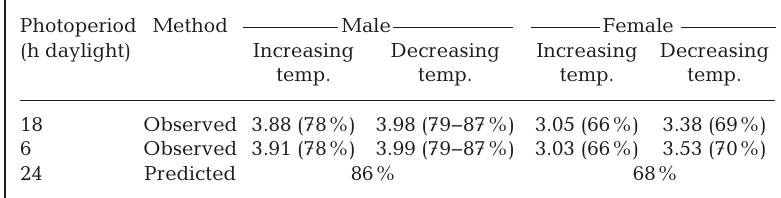
Table 6. Effects of temperature gradient and light regime on Lepeophtheirus salmo- nis development. The table shows the mean number of molts undertaken by males and females when temperatures increase from 6 to 11.4°C during development to preadults in a long-day regime and a short-day regime, likewise when temperatures decrease from 11.4 to 6°C. The observed relative age (%) is given in brackets. The growth model used to calculate the predicted relative age was derived from data ob- tained at 24 h daylight and stable temperatures. Note that the lice were sampled in a period when the female population was in a phase of molting from preadult 1 to preadult 2, whereas the male population was close to (increasing temperature group) or in in a phase when no molts take place (decreasing temperature group). Thus, for males MnM » 4 in the period from about 79 to 87% relative age (see Fig. 5)